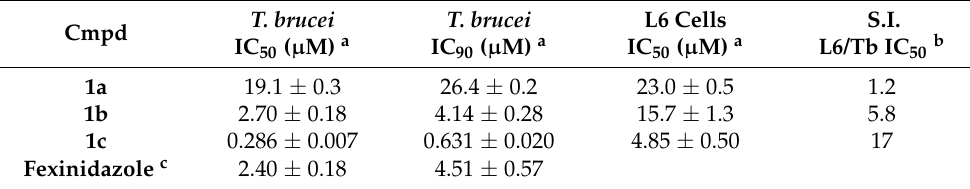
Table 1. Anti- T. brucei screening of derivatives 1a – c . Cmpd